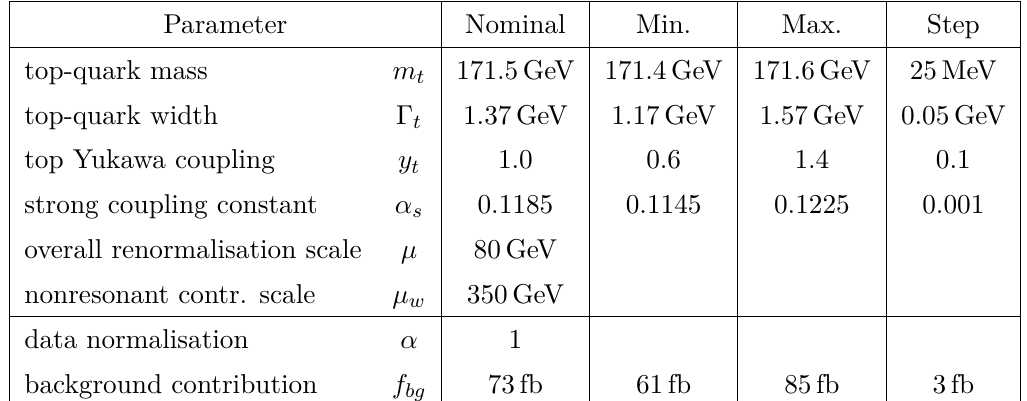
Table 1 . Parameters used as an input to QQbar_threshold (upper part of the table) and nor- malisation uncertainties considered in the analysis (lower part). Top-quark Yukawa coupling, y is given relative to SM predictions. Overall renormalisation scale, µ , and the energy scale for non- resonant contributions, µ , were not varied in the described study. Range and step values are also w not indicated for the overall data normalisation factor α , as it is evaluated analytically in the fit procedure (see section 3.2 for